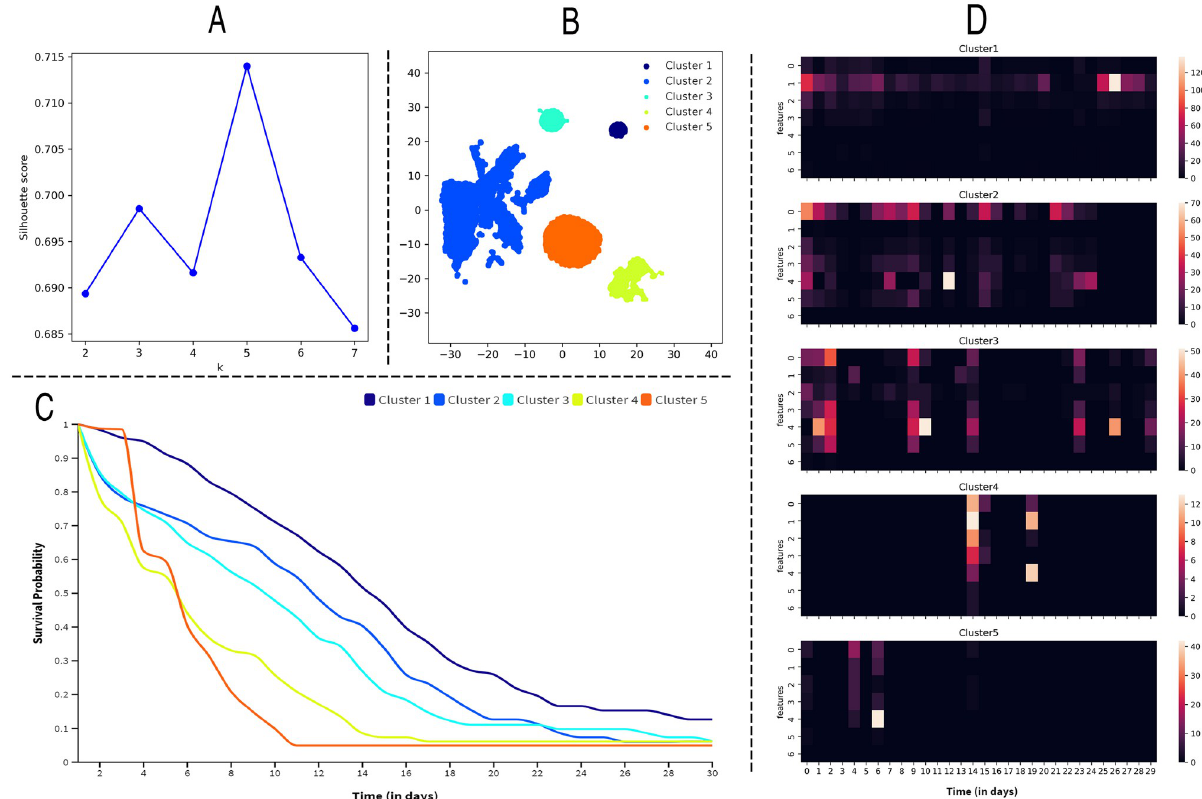
Fig 5. A case study of SAVSNet. A: The silhouette scores of clusters from 2 to 7. B: Exhibiting unsupervised clustering into 5 clusters. C: Comparison of the survival probability curves of the representative instance in 5 clusters. D: A set of heatmaps showing longitudinal and multivariate learning activities for the 5 representative